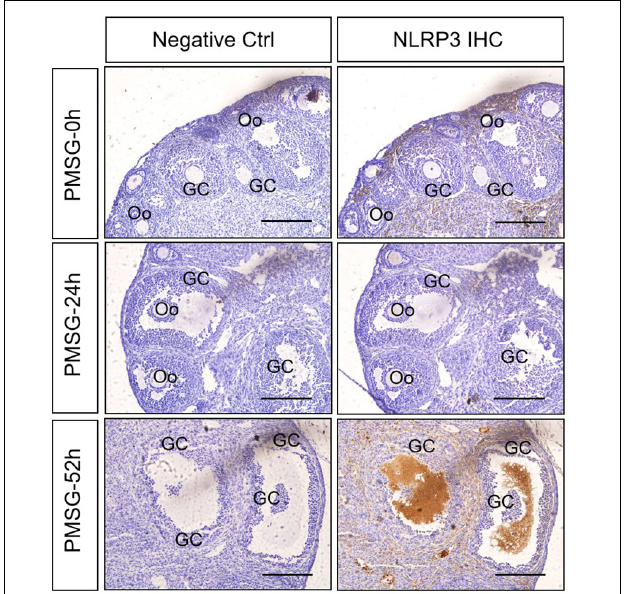
FIGURE 1 | NLRP3 immunohistochemistry in the ovary during the follicular development induced by PMSG Ovarian sections were immunostained for NLRP3 and counterstained with hematoxylin. The NLRP3 immunohistochemical signals appear brown, and the background counterstaining appears blue. Negative control remained unstained, lacking primary antibody instead of serum. GC, granulosa cell; Oo, oocyte; bar = 100 µ m.